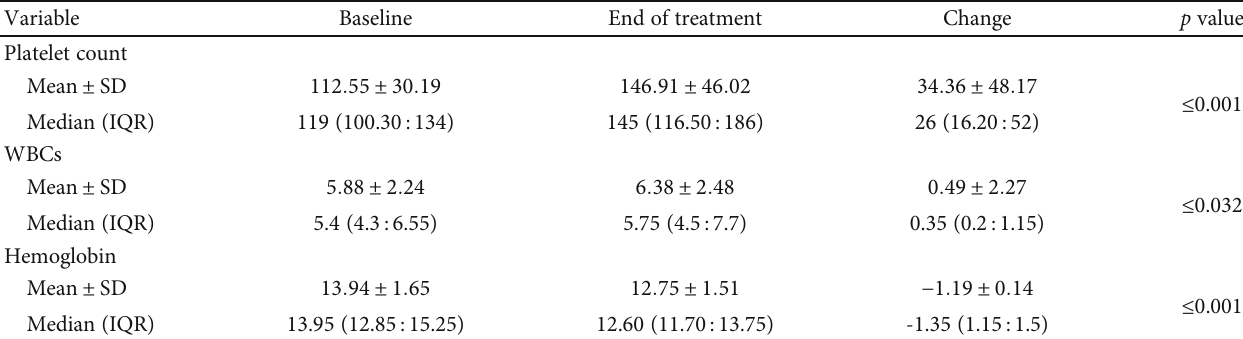
Table 2: Hematological changes following antiviral therapy.